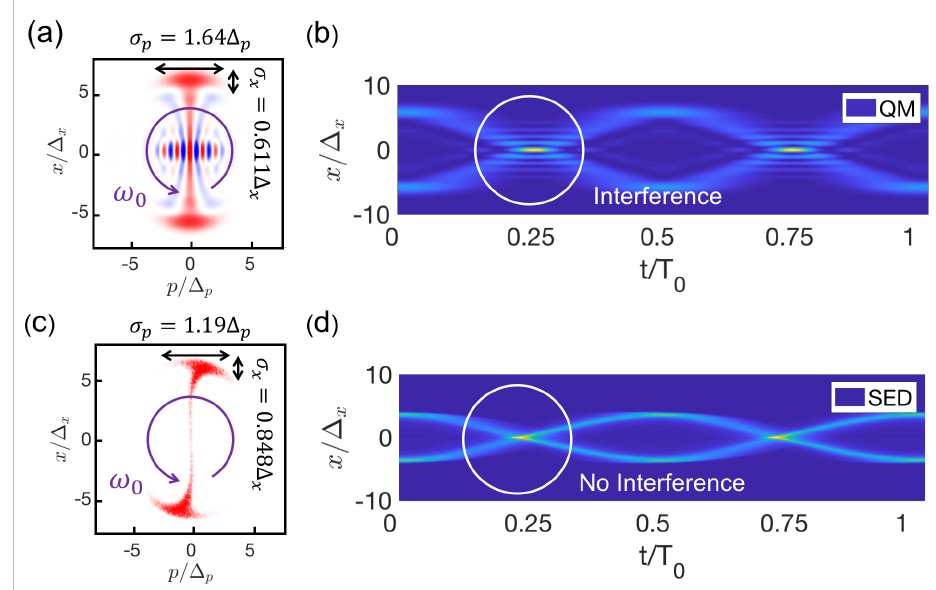
Figure 2. Time evolution of quantum mechanics (QM) and stochastic electrodynamics (SED) probability distributions after laser excitation. ( a ) The Wigner function of the QM oscillator is plotted after the laser excitation. Positive values are color-coded in red, and negative values are in blue. Quantum coherence between the two well-separated squeezed states is manifested by the fringe structure in the center. The Wigner function rotates counter-clockwise at the oscillator’s resonant frequency ω 0 = 10 16 (rad/s). At the moment when the distribution is depicted, the position quadrature uncertainty σ x of the √ squeezed state is smaller than that of the ground state ∆ x = ¯ h /2 m ω 0 . Meanwhile, the quadrature uncertainty product satisfies the Heisenberg relation σ x σ p = ¯ h /2 at all times. ( b ) The two wavepackets oscillate back and forth in the harmonic potential, giving rise to a double sinusoidal trajectory of the QM probability distribution. An interference pattern appears when the two wavepackets merge. ( c ) The phase space distribution of the SED oscillator shows two well-separated sub-ensembles. Each sub-ensemble has a squeezed structure that mimics the QM squeezed state shown in ( a ). ( d ) As the SED phase space distribution rotates counter-clockwise, the probability distribution bundles into two “macroscopic” trajectories. In each trial of the SED simulation, there is no knowledge which macroscopic trajectory a particle will follow unless the initial phase of the background zero-point field is known. No interference-like patterns are found in the SED probability distribution when the two macroscopic trajectories of distributions